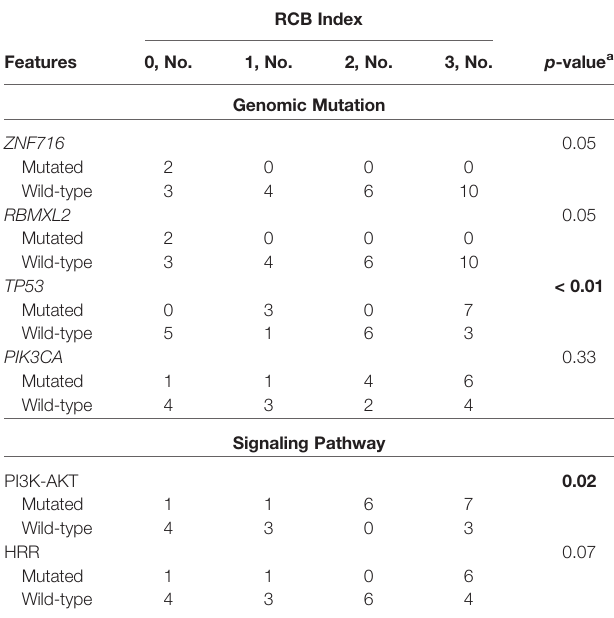
FIGURE 2 | Genetic pro fi le of baseline tumor tissue samples. The baseline tumor tissue samples of 25 patients were performed by WES. Altered genes of the phosphatidylinositol-3-kinase-AKT (PI3K-AKT) pathway and homologous recombinational repair (HRR) pathway and altered genes over 10% frequency were displayed. The most frequently altered genes were PIK3CA , TP53 , DDX11 , MUC4 , QRICH2 , and TTN . PIK3CA and TP53 mutations were enriched in patients not achieving pCR, and mutated PI3K- AKT pathway and HRR pathway were also more frequently observed in patients not achieving pCR.